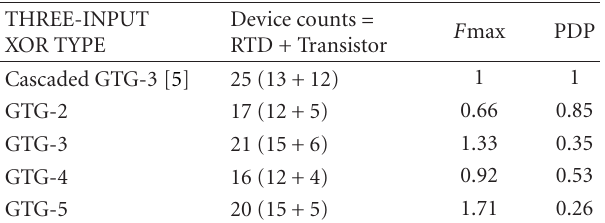
Table 1: Comparison between single gates and cascaded gates of three-input XOR logic based on MOBILE structure. The results are normalized based on GTG-2 result except second column (PDP = (Power at F max)/ F